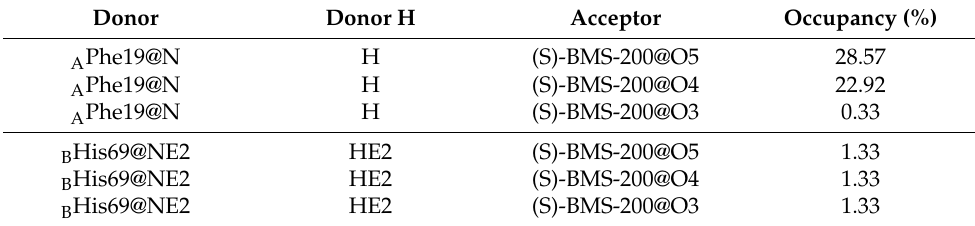
Table 3. Hydrogen bond occupancies of the S system.